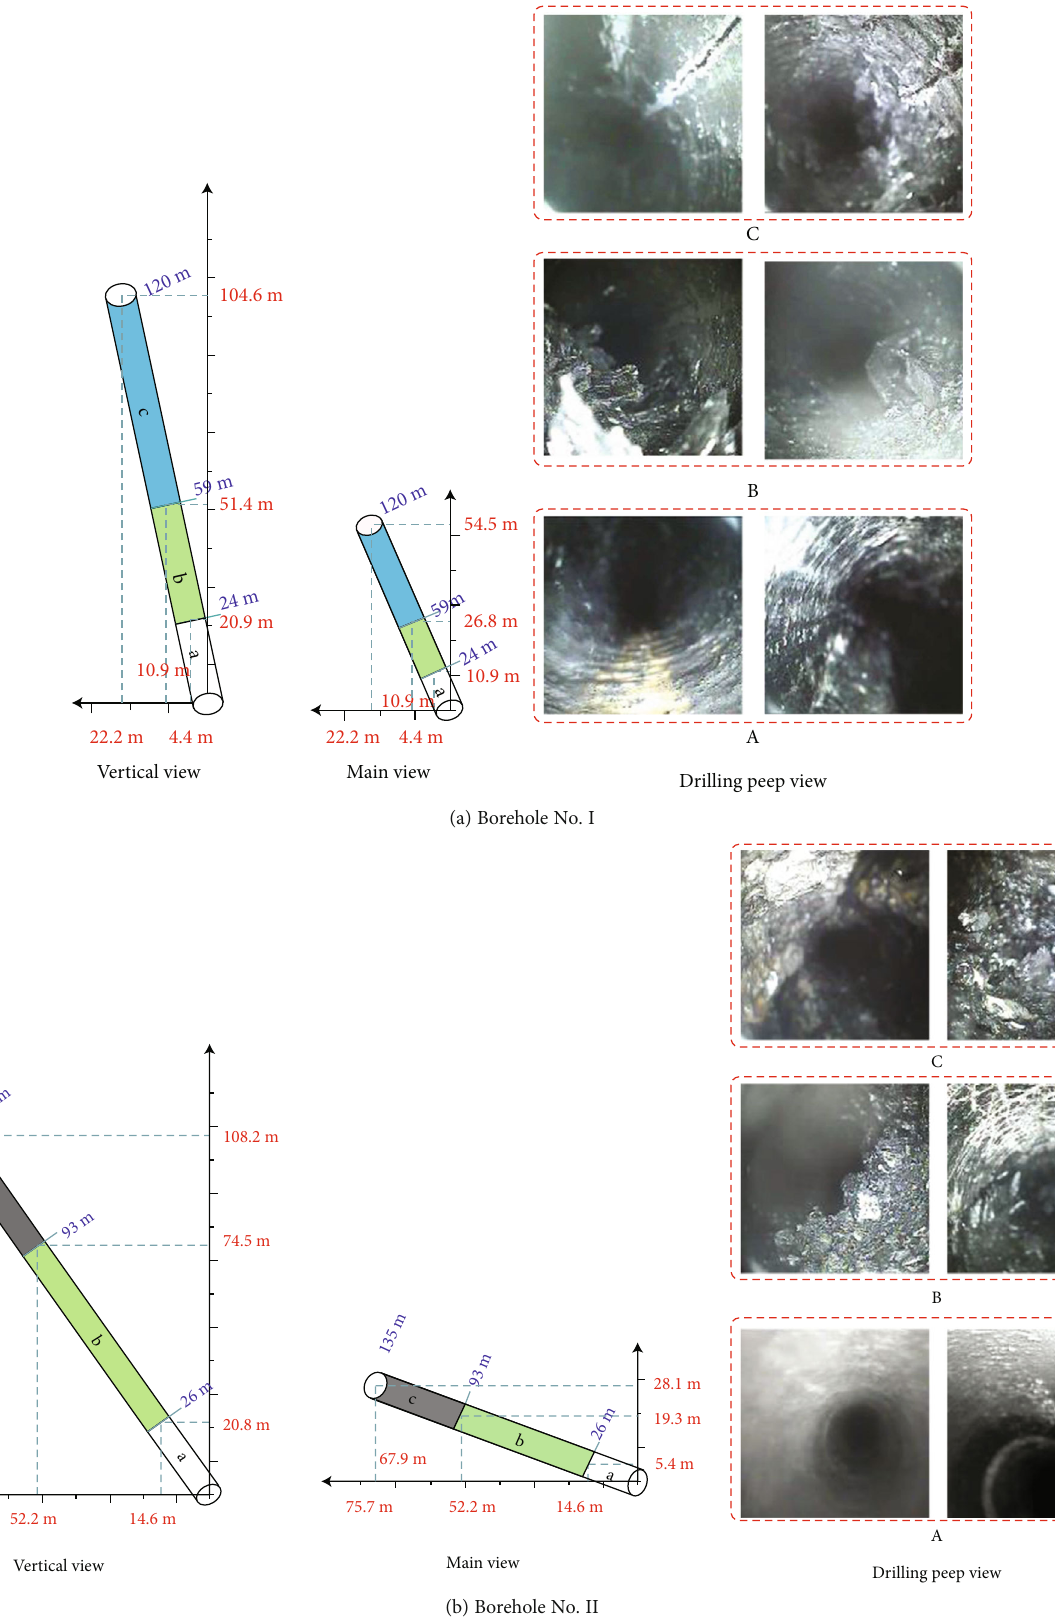
Figure 6: Observation results of drill holes during